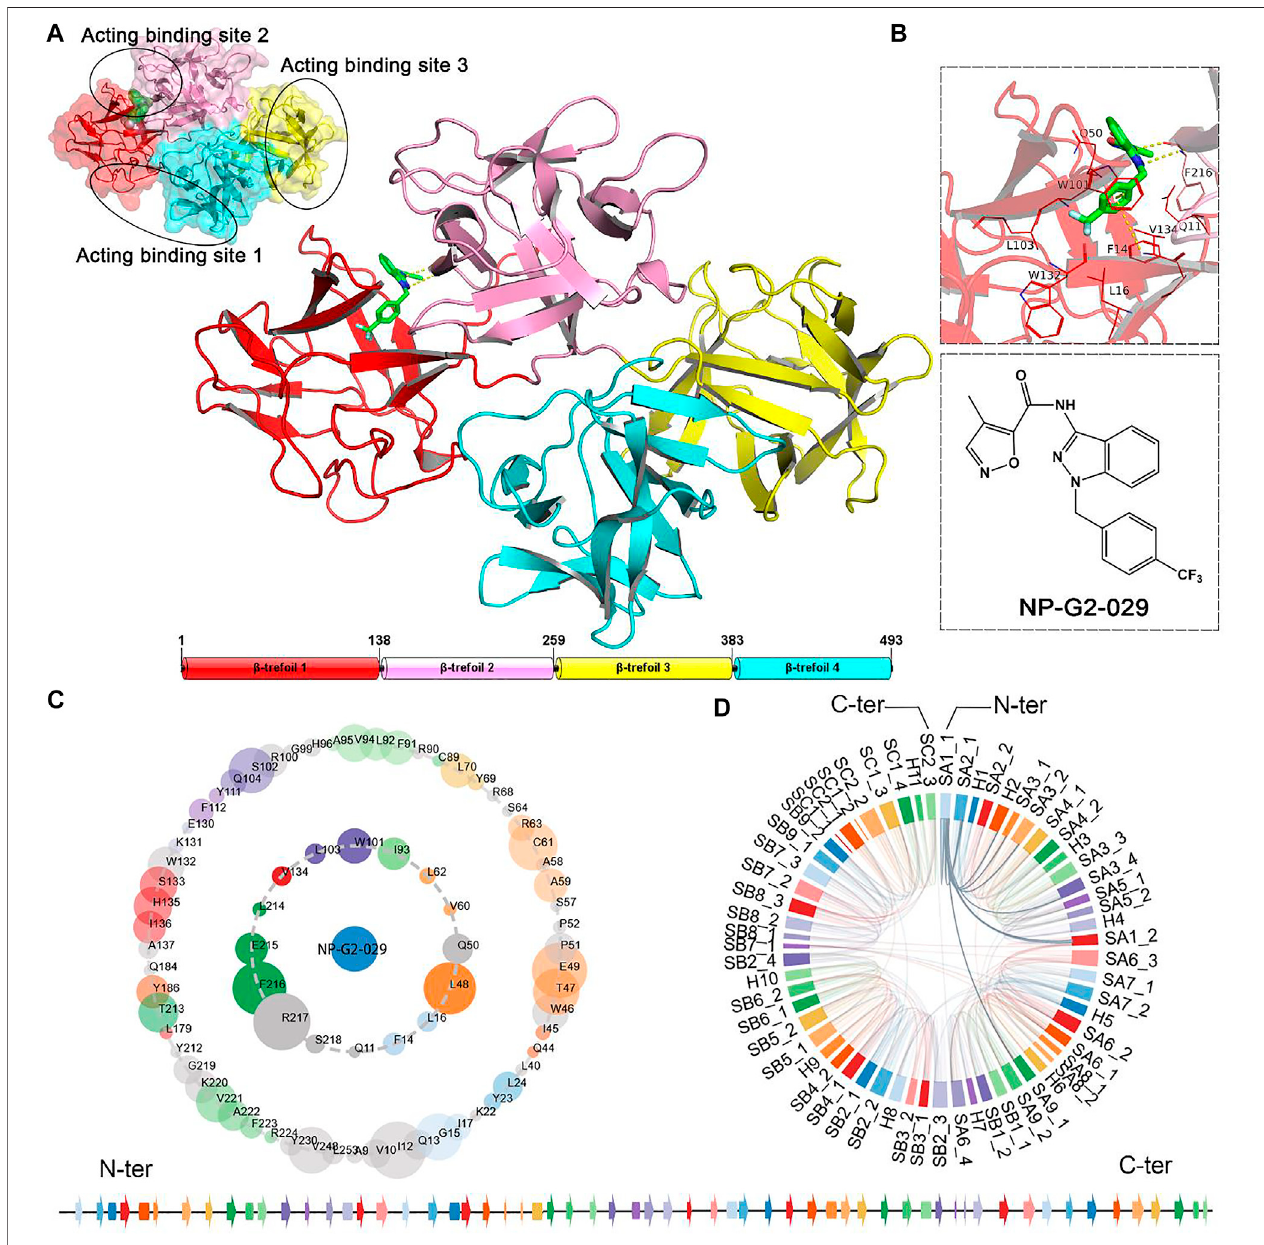
FIGURE 1 | (A) The structure of the Fascin-inhibitor complex. Junctions between β -trefoils 1 and 2, β -trefoils 1 and 4 contain two actin-binding sites respectively, andanotheractin-bindingsitelocateson β -trefoils3( Figure1A ). (B) InhibitorNP-G02-029andthebindingpocket. (C) Protein − NP-G2-029interactionsarerepresented byanasteroidplot.Theinnerringrepresentsdirectinteractions.Theouterringrepresentsindirectinteractions.Thesizeoftheballistheinteraction-numberproportionin atomic scale. The colors of residues correspond to their secondary structures. (D) Secondary structure connection of Fascin. The bottom panel shows the secondary structure ( β -sheets and α helixes) with their respective colors. Arrows stand for β -sheets, rectangles stand for α helix. N-ter, N terminus; C-ter, C terminus. PDB ID: 6B0T. Structure visualized by PyMOL (Rigsby and Parker, 2016).